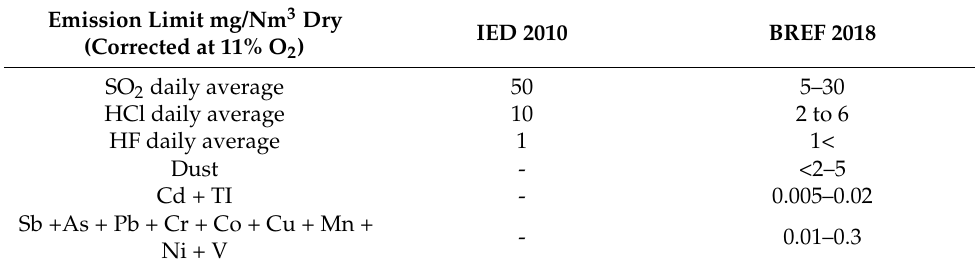
Table 9. Evolution of the emission limit value for waste incineration between the industrial emission directive (IED) and the latest waste incineration (WI) best available technique reference (BREF) document (for heavy metals the average is taken over the sampling period)